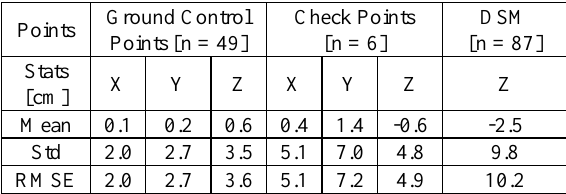
Table 2. Achieved accuracies for Kapilvastu